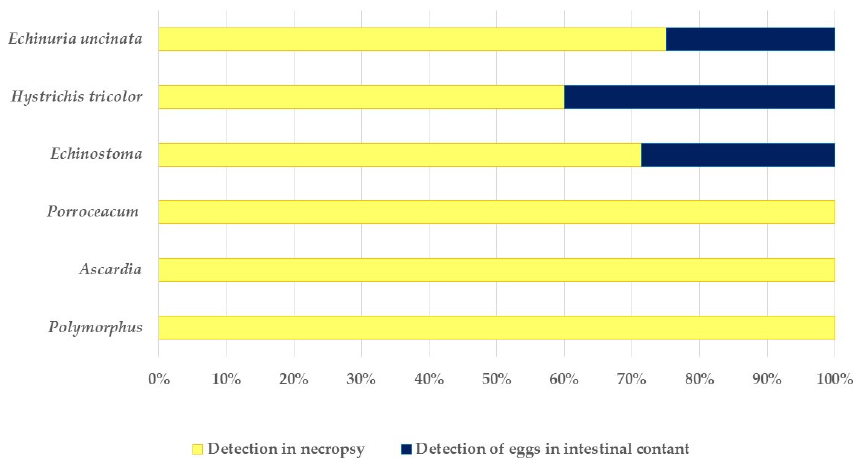
Figure 4. Types of verification of different endoparasitic parasites in carcasses of Alopochen aegyptiaca adults in the intestine vs. excreted eggs in the intestine in the same animals. Depending on the parasite species, a different patency can be recognised in this alien host. Patent infections clearly show that the parasite can not only infect this alien bird but also reproduce in it.